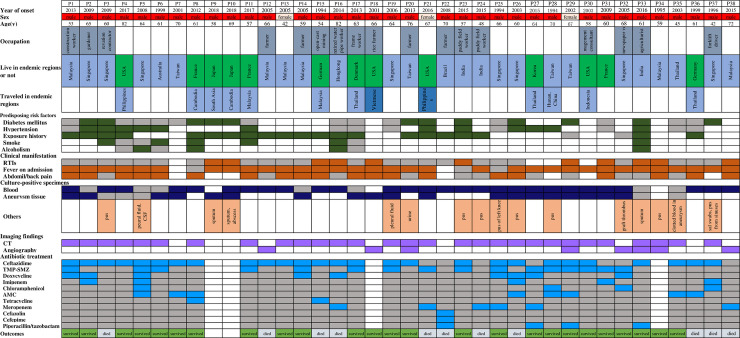
Summary of the 38reported cases of mycotic aneurysm secondary to melioidosis in the literature.RTI: Respiratory tract infections; CT: computed tomography; TMP-SMZ: trimethoprim/sulfamethoxazole; AMC: amoxicillin/clavulanate; Blank cell: data not available; Grey cell: no; other colored cells: yes. Cases, including Case 1 [21], Case 2–3 [4], Case 4 [1],Case 5 [20],Case 6 [22],Case 7 [48],Case 8 [9], Case 9–10 [23], Case 11 [24], Case 12–14 [25], Case 15 [26], Case 16 [3], Case 17 [27], Case 18 [28], Case 19 [29], Case 20 [30], Case 21 [31], Case 22 [19], Case 23–24 [6], and Case 25–26 [10], Case 27 [52], Case 28 [18], Case 29 [32], Case 30 [33], Case 31 [41], Case 32 [35], Case 33 [36], Case 34 [8] Case 35 [37], Case36 [38], Case37 [39], and Case38 [40].